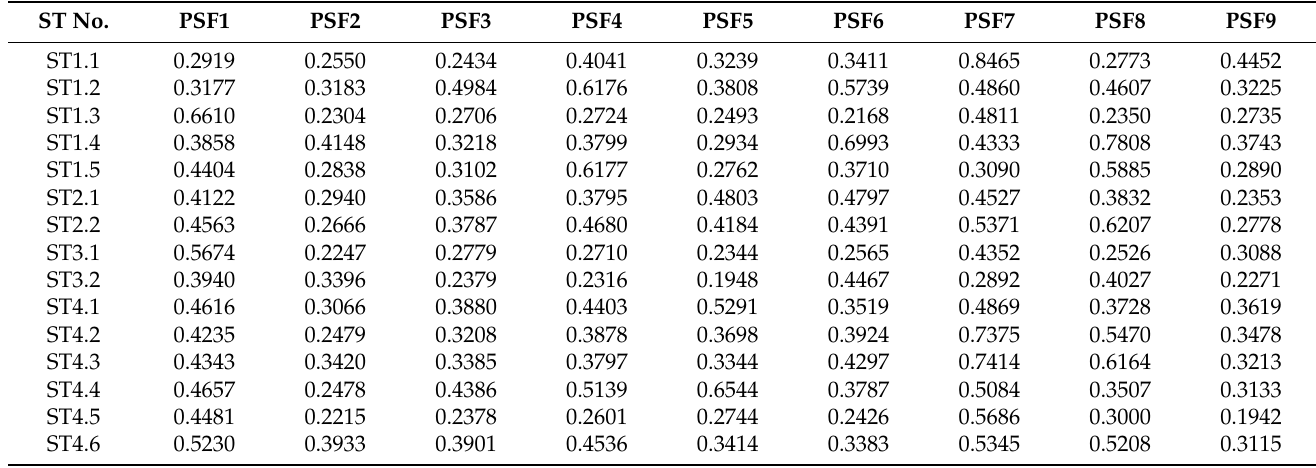
Table 12. Risk-based grey relational degree of each PSF in each